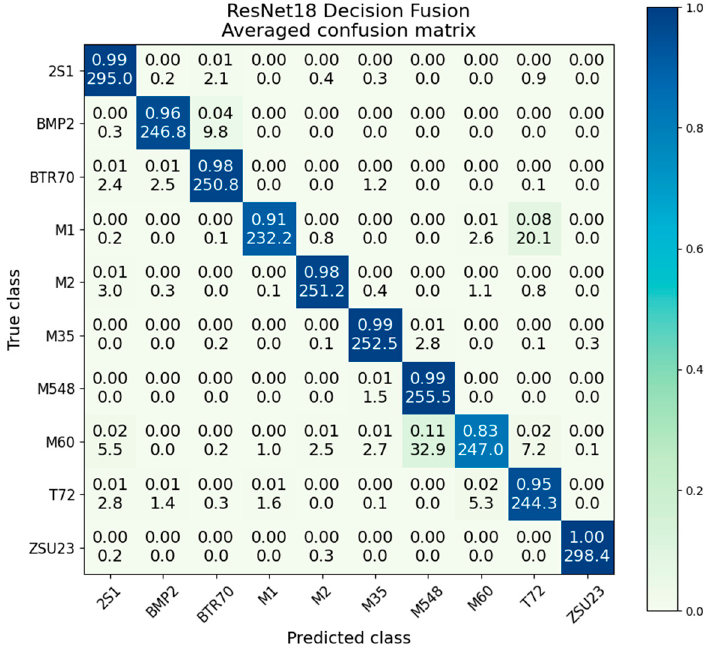
Table 6. ResNet18 decision fusion intraclass variance (Var) and standard deviation (SD). Class